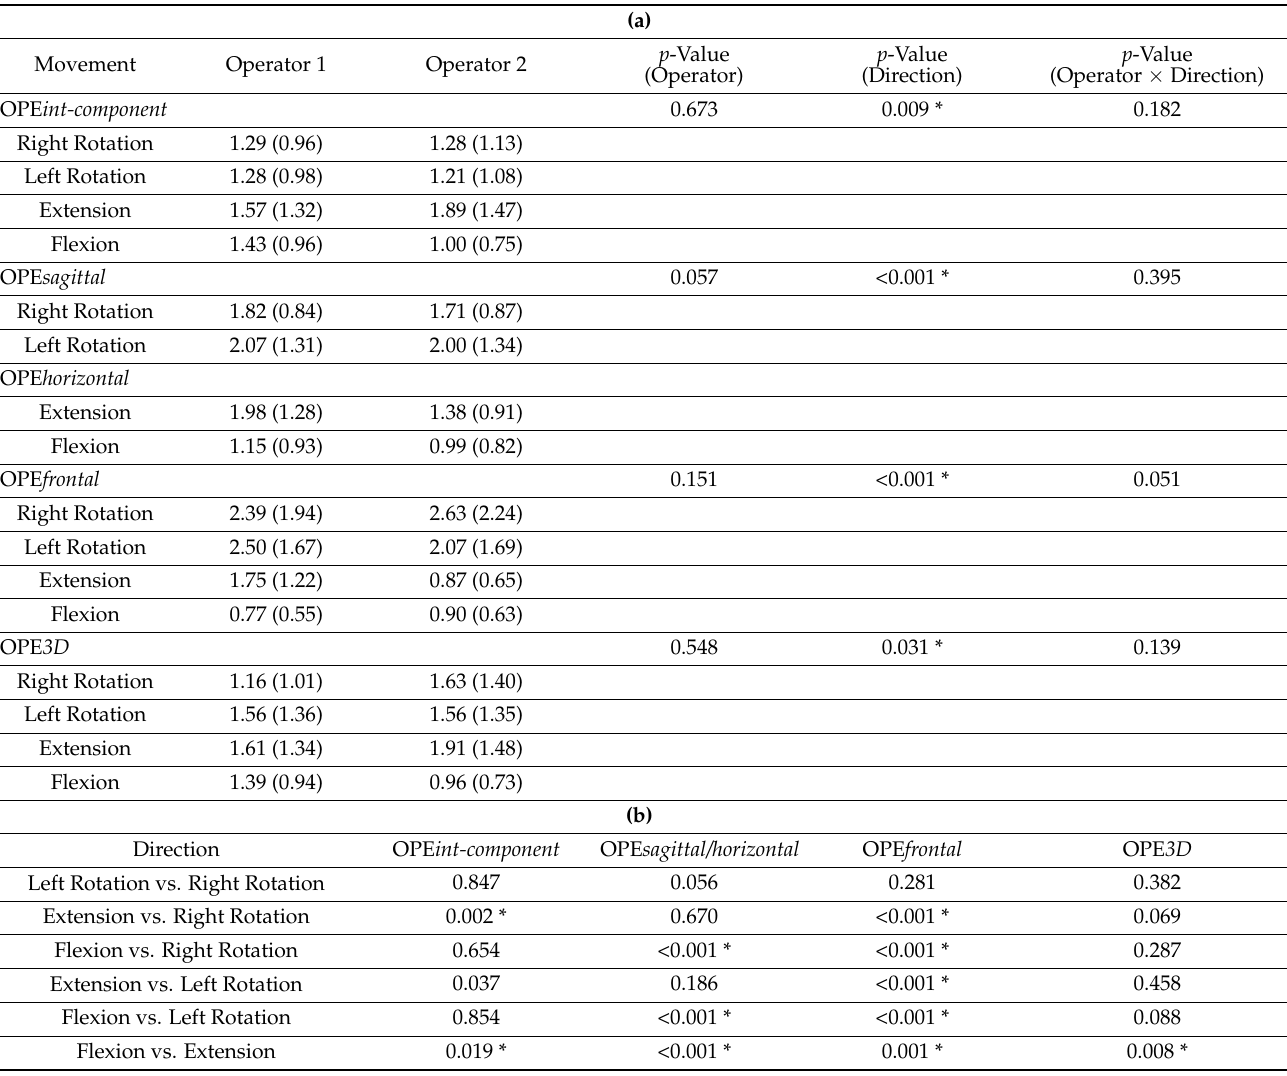
Table 2. (a) Mean (standard deviation) in degrees ( ◦ ) and ANOVA results for Operator Position Error (OPE) outcomes. (b) Post hoc Student’s t -test on contrasts between pairs for OPE int-component and OPE 3D for the “Direction” factor. The p -value was set at p < 0.05.